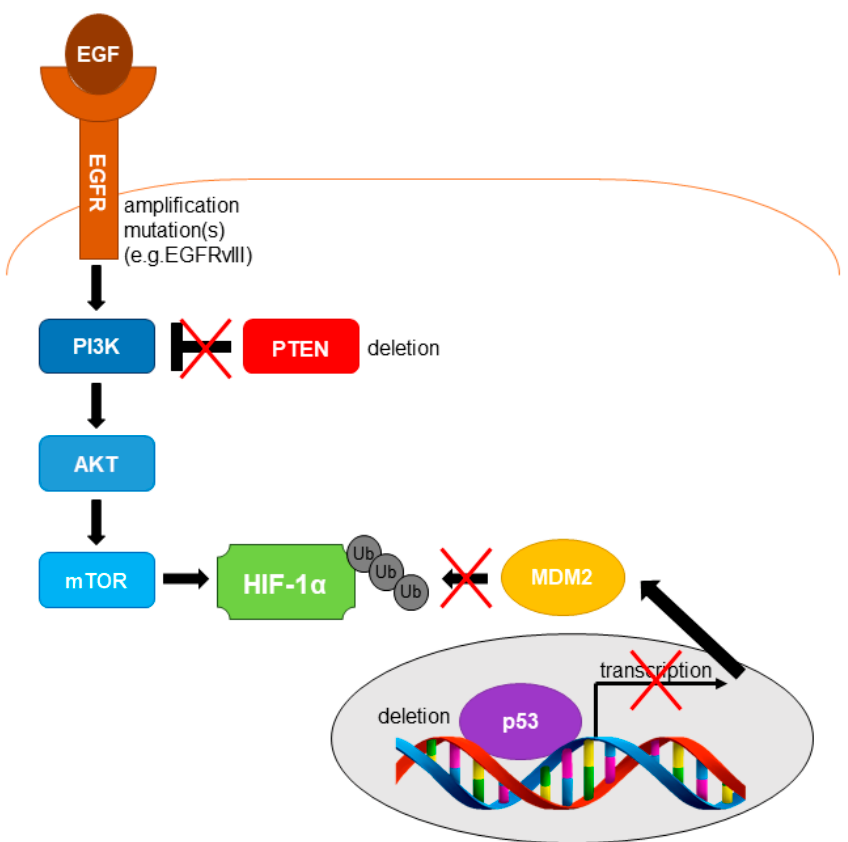
Figure 3. Genetic alterations leading to HIF activation in GB. Activation of the Epidermal Growth Factor Receptor (EGFR) by EGFR gene mutation (e.g., EGFRvIII) and/or amplification frequently occurs in GB cells resulting in activation of the PI3K/AKT/mTOR pathway with the subsequent accumulation of HIF-1 α levels. The tumor suppressor Phosphatase and Tensin homolog ( PTEN ) gene is deleted in 20–40% of GBs. PTEN is the main inhibitor of the PI3K/AKT signaling pathway. Consequently, loss of PTEN will also lead to accumulation of HIF-1 α via the PI3K/AKT/mTOR pathway. Loss of p53 inhibits MDM2-mediated ubiquitination of HIF-1 α leading to its accumulation and increased HIF activity in GB cells.